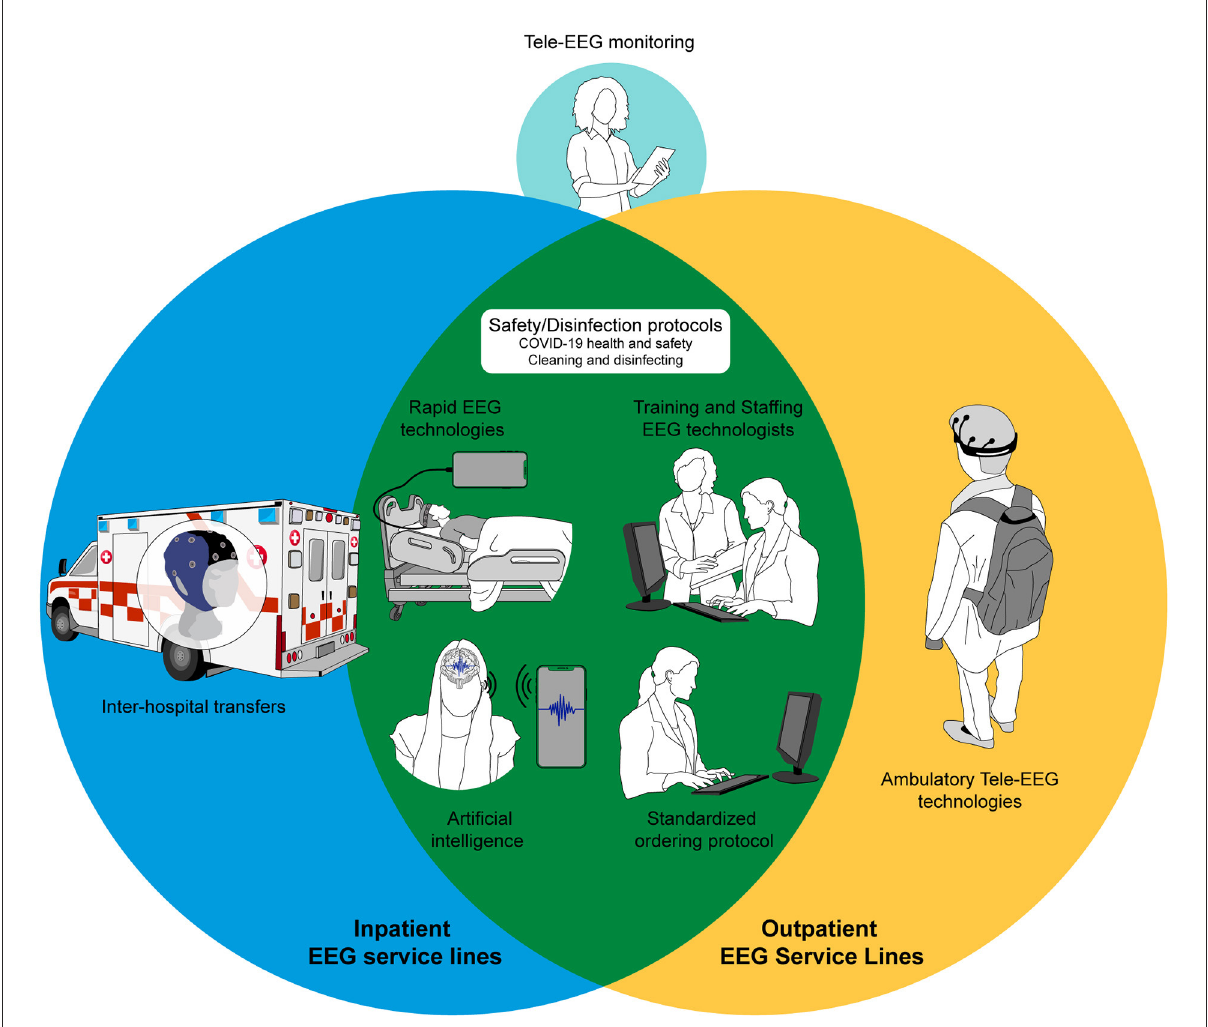
FIGURE1 Illustration showing components for an ideal pandemic-proof EEG service